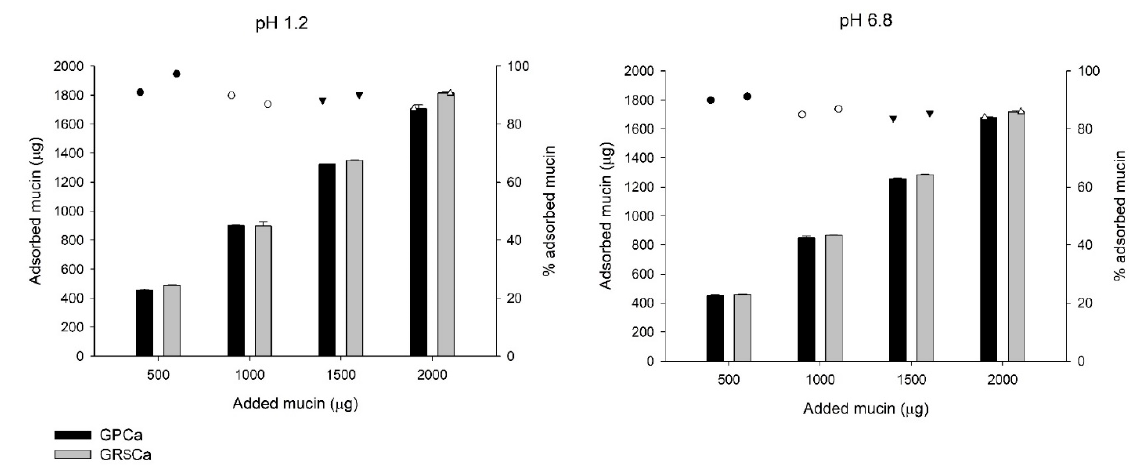
Figure 6. Amount of mucin adsorbed by the microparticles as a function of the amount of mucin added to the solutions (represented by the bars) and percentage of adsorbed mucin (represented by the dots).